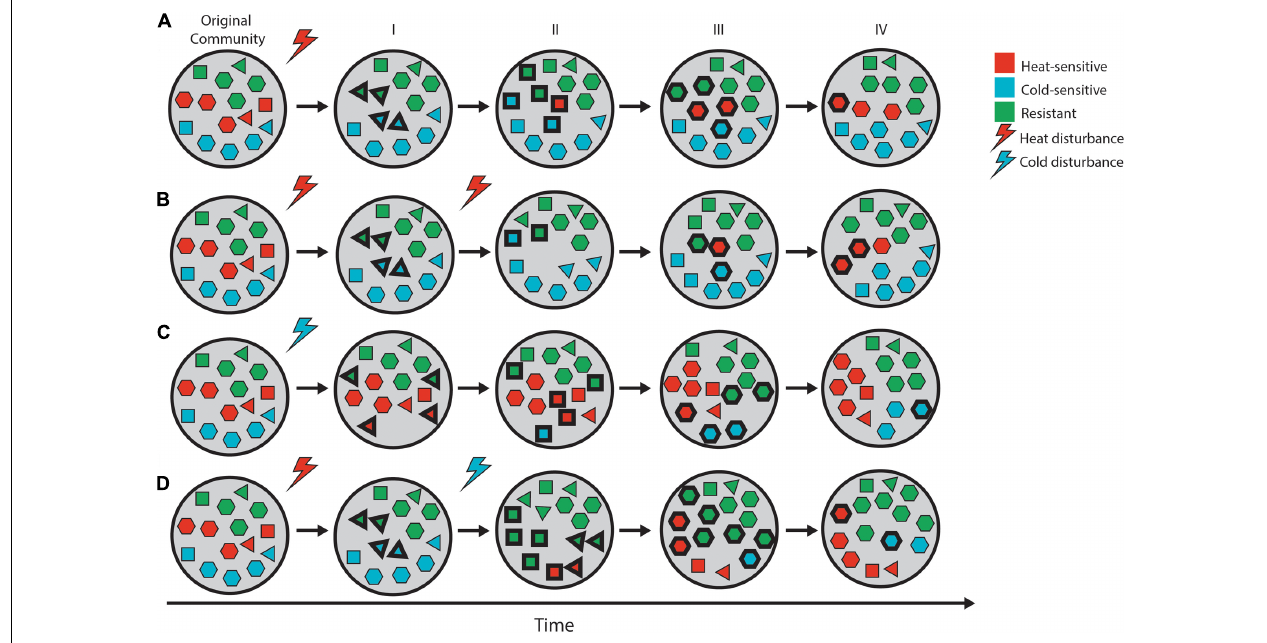
FIGURE 1 | Schematic of microbial community recovery from pulse disturbance over time. Shape-color combinations represent different microbial taxa, and bold outlines highlight “new” taxa drawn from a local pool. The initial stages of community recovery are highly dependent on disturbance type ( A —heat, C —cold), as sensitive individuals are removed from the system and survivors compete to consume the newly available resources (I). Over time, the sensitive taxa return to the system, compete with the survivors to increase their abundance (II, III), and may eventually reach a structure similar to that of the pre-disturbance community (IV). The effect of compounded perturbation depends on the disturbance type as well. In the case of homogeneous perturbation (B) , the second disturbance has little effect on the community, as the sensitive organisms have already been removed from the system by the initial (legacy) disturbance. The effects are expected to be multiplicative in the case of mixed perturbation (D) , as additional organisms are removed from the community by the second disturbance, resulting in a less diverse community that is less able to reorganize and recover following